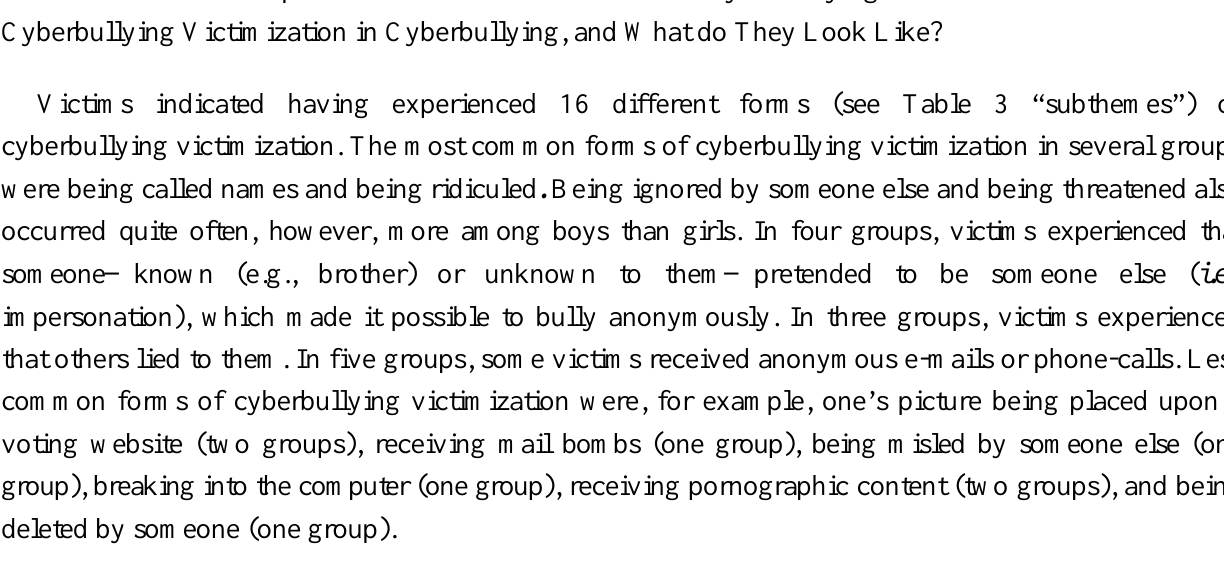
Table 3. Main themes, subthemes and examples for experiences with traditional and cyberbullying. Final Themes